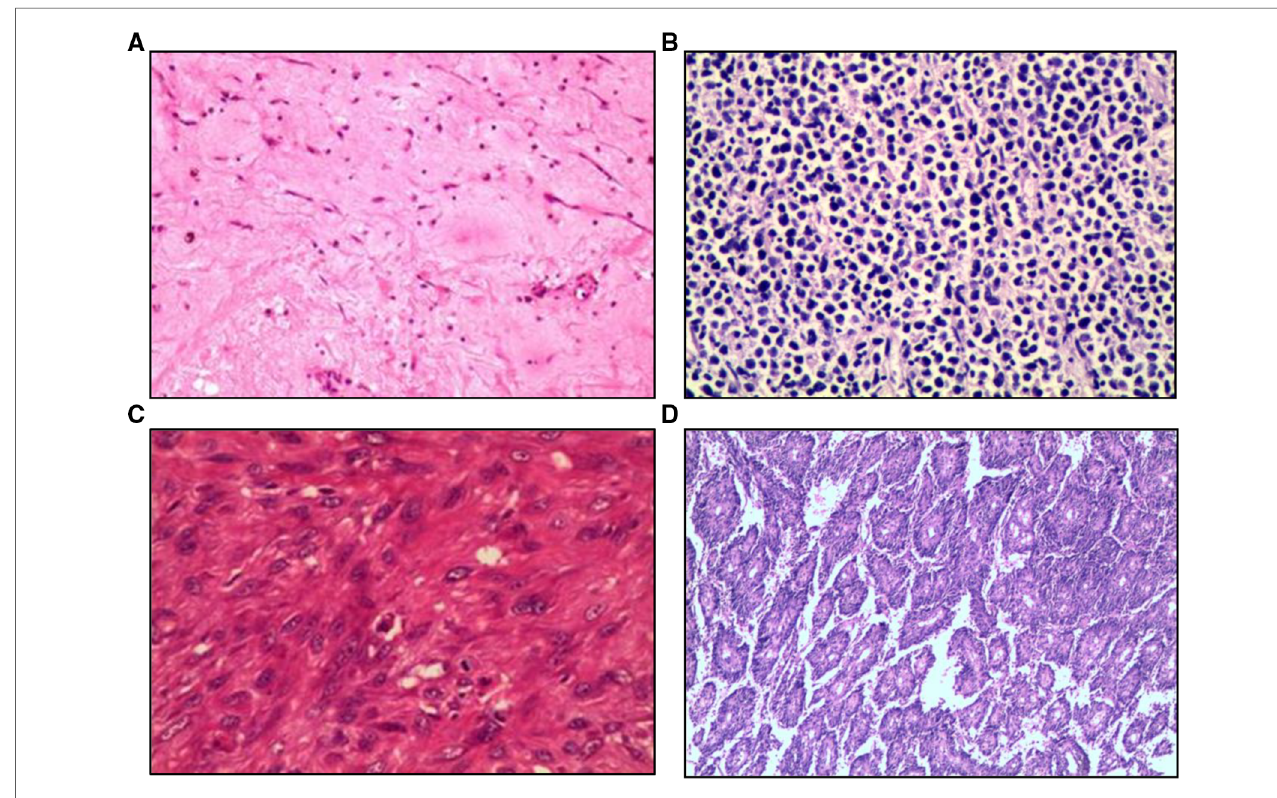
FIGURE 4 Pathological section images of patients with benign or malignant primary atrial tumor. ( A ) Cardiac myxoma. ( B ) Diffuse large B cell lymphoma. ( C ) Intimal sarcoma. ( D ) Angiosarcoma.